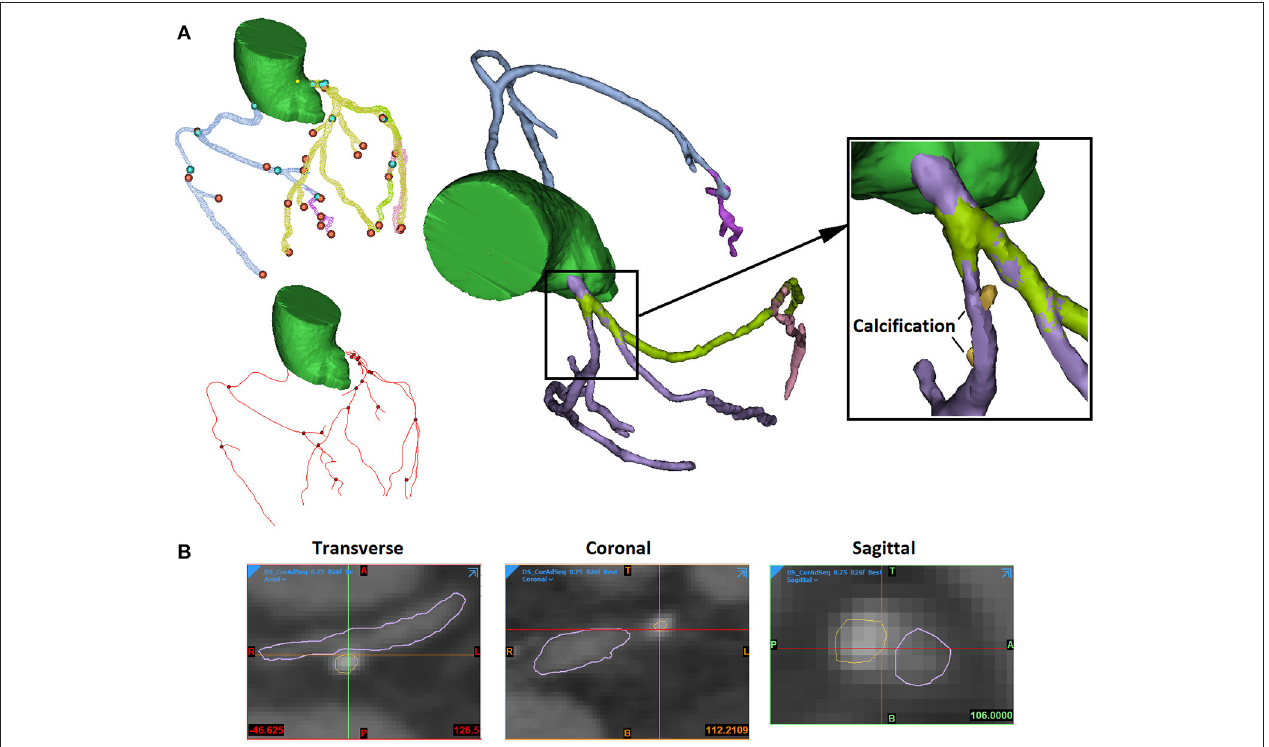
FIGURE 1 | The extraction of arterial lumen and calcification. (A) The 3D view. The blue and orange points present the start and the end points of extracted artery segments. The red lines and black points present the centerlines of artery segments and connecting points (left). The arterial segments were extracted in different masks (in different colours) and connected (middle). The calcifications were extracted independently (right). (B) The 2D views of stenosed artery in three directions (sagittal, coronal, and